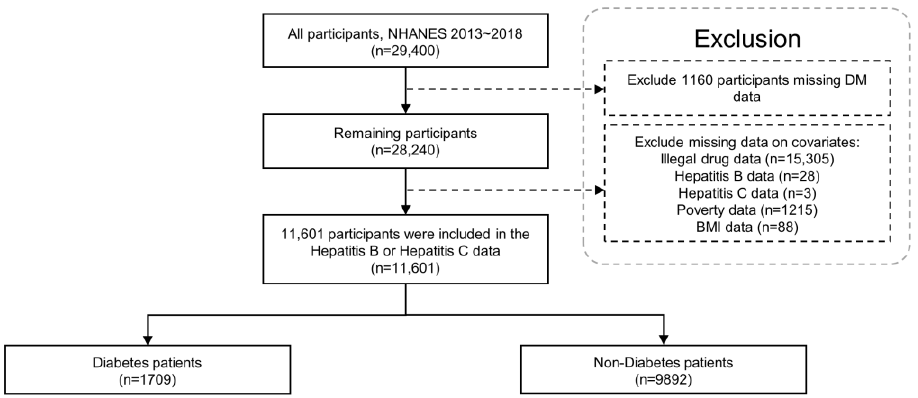
Figure 1. Flowchart of the study participants using the NHANES 2013–2018. BMI: body mass index; NHANES: National Health and Nutrition Examination Survey. Table 1. Baseline characteristics of the study population from the National Health and Nutrition Examination Survey (NHANES)